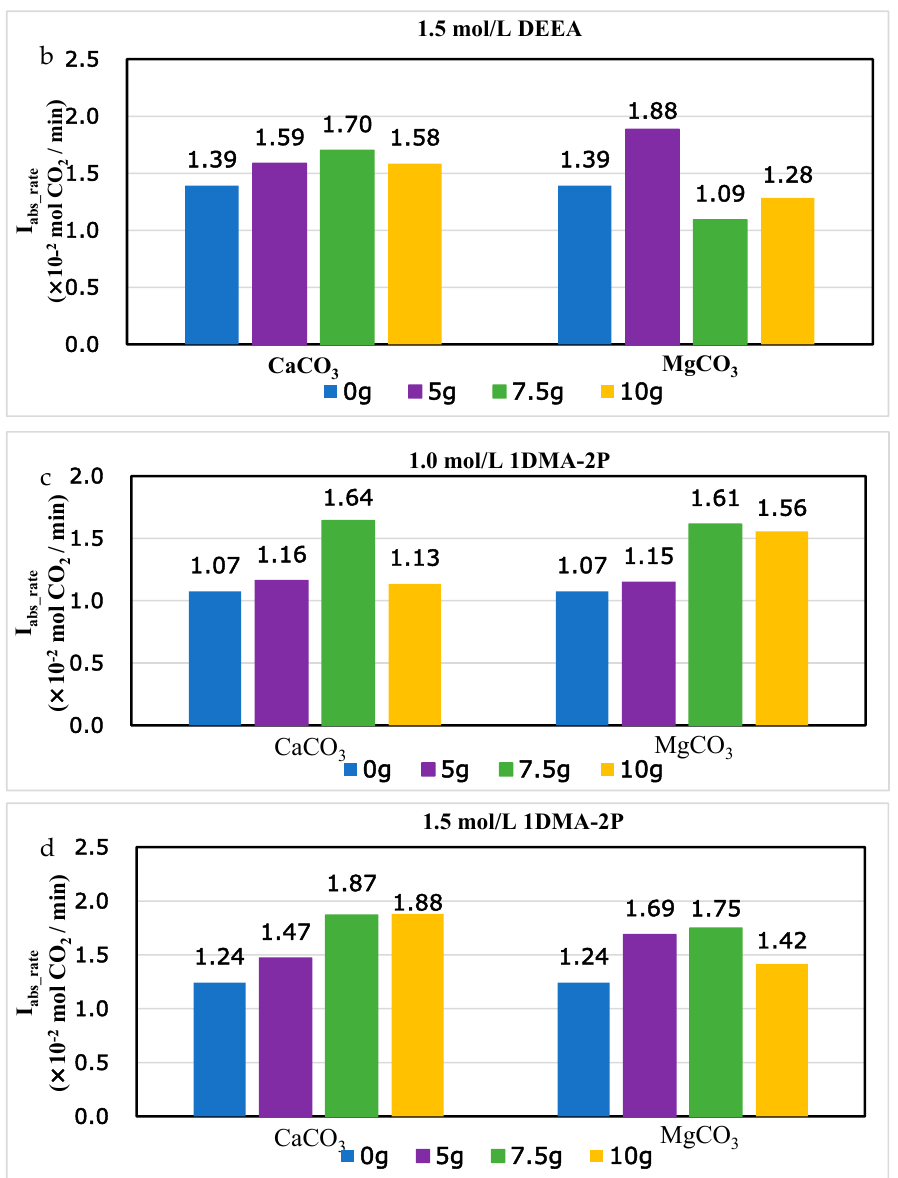
Figure 7. Initial Absorption rates for DEEA and 1DMA-2P with optimized amount of CaCO 3 and MgCO 3 , from 1.0–1.5 mol/L at 293 K and 1 atm. ( a ) 1.0 mol/L DEEA, ( b ) 1.5 mol/L DEEA, ( c ) 1.0 mol/L 1DMA-2P, ( d ) 1.5 mol/L 1DMA-2P.